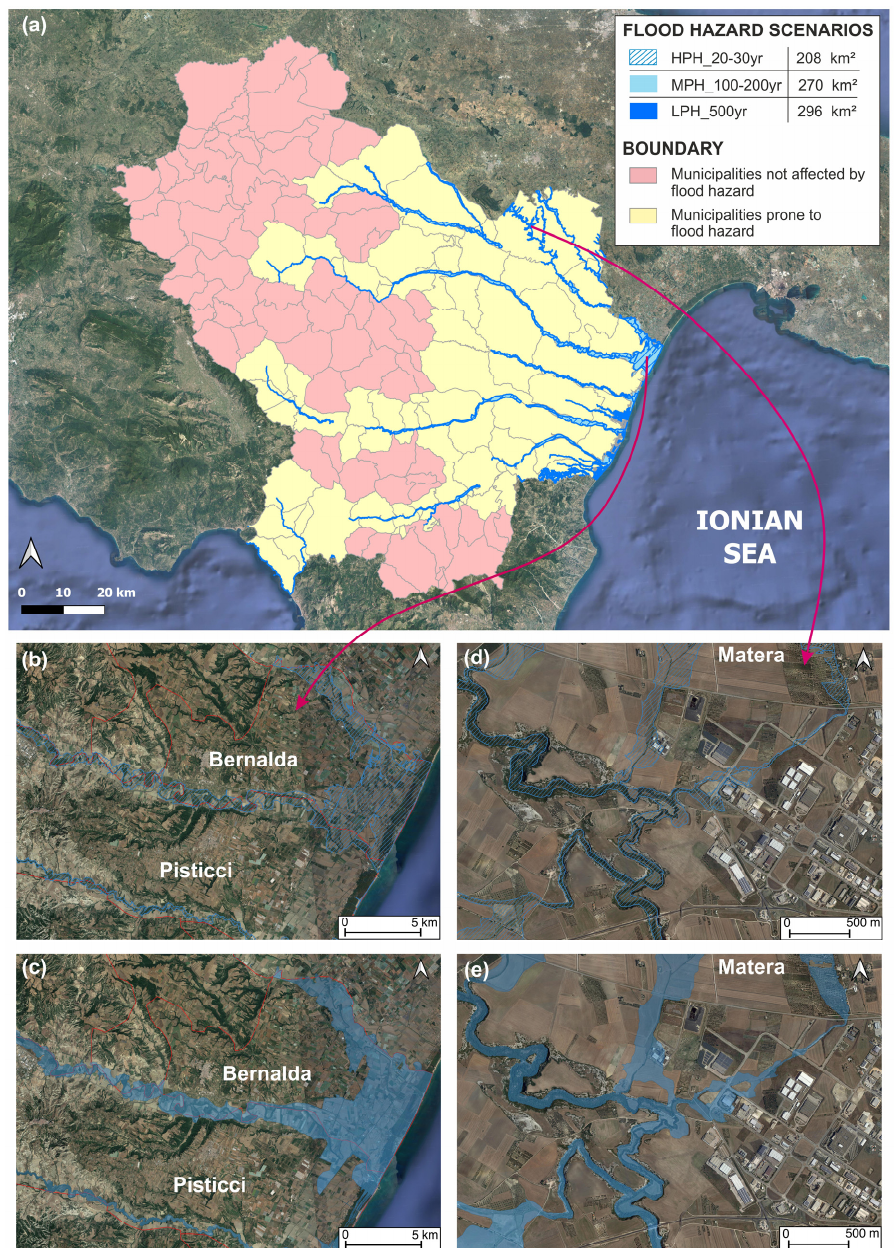
Figure 3. ( a ) Map showing the main municipalities (yellow color) prone to flood hazard in Basilicata Region. The areal extension of each scenario is represented in the legend. HPH = High probability flood; MPH = Medium probability flood; LHP = Low probability flood. ( b ) Spot of Bernalda and Pisticci in HPH and ( c ) LPH scenarios; the red line represents the administrative boundary at the municipality level. ( d ) Spot of Matera in HPH and ( e ) LPH scenarios.